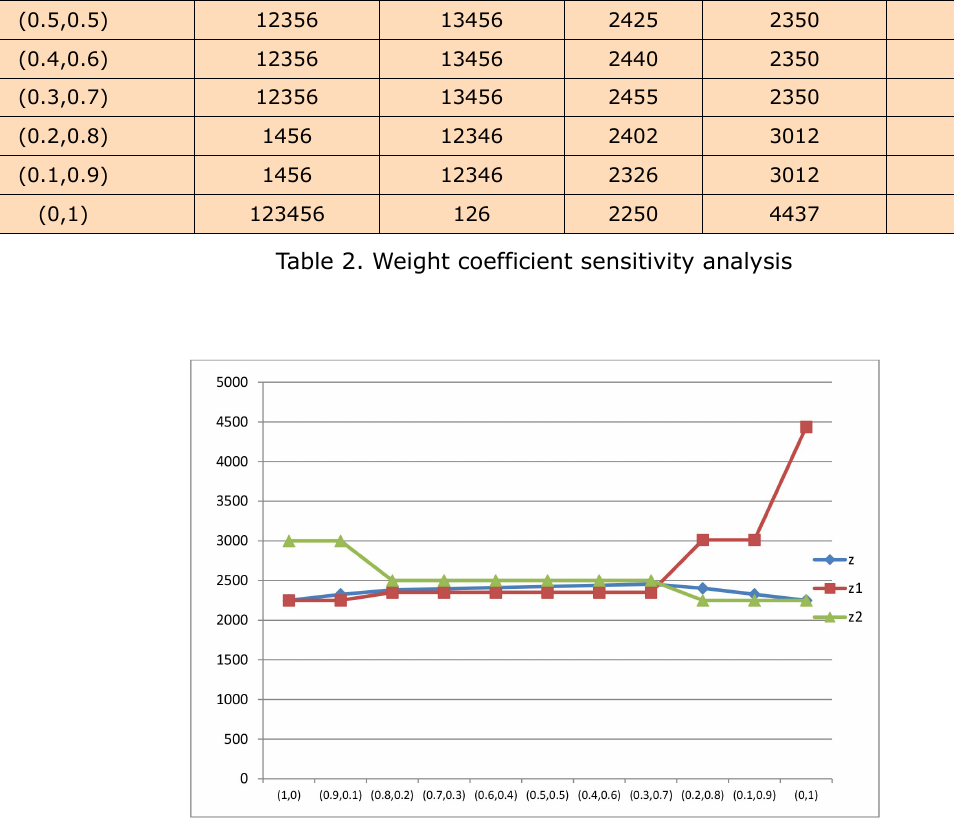
Figure 2. Weight coefficient sensitivity